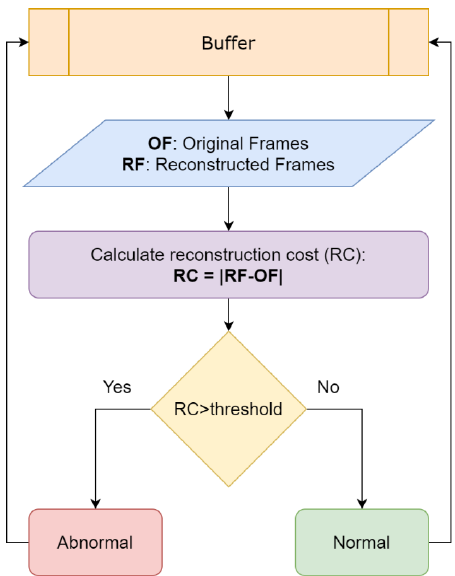
Figure 12. Decision flow: A high reconstruction cost between OF and RF indicates an abnormal event.